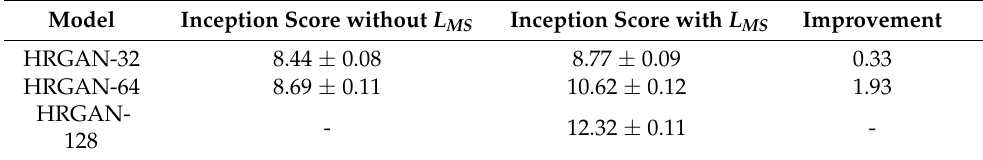
Table 2. The Inception scores with and without the Inception score